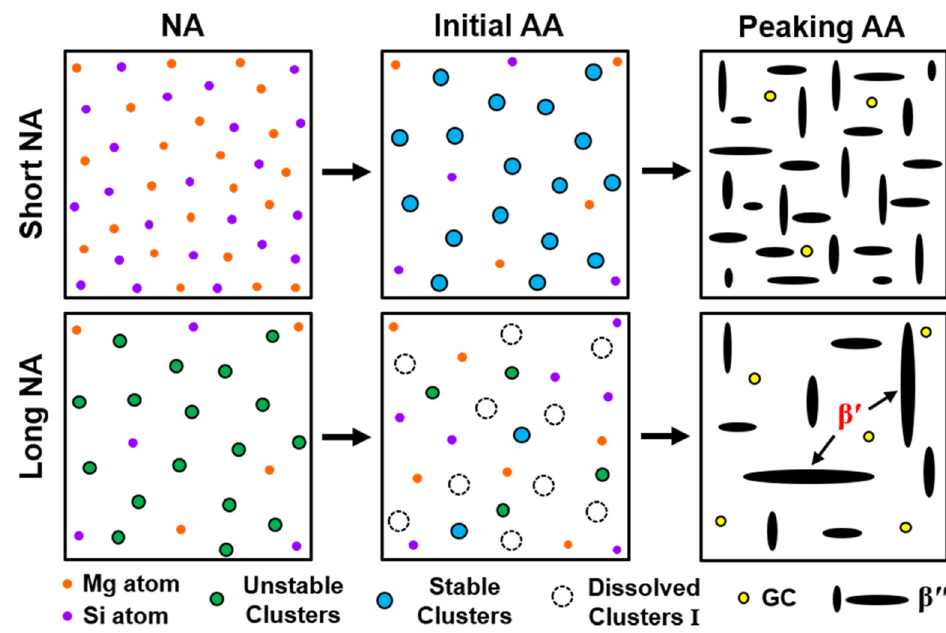
Figure 7. The schematic diagram of the AA process of short NA and long NA.